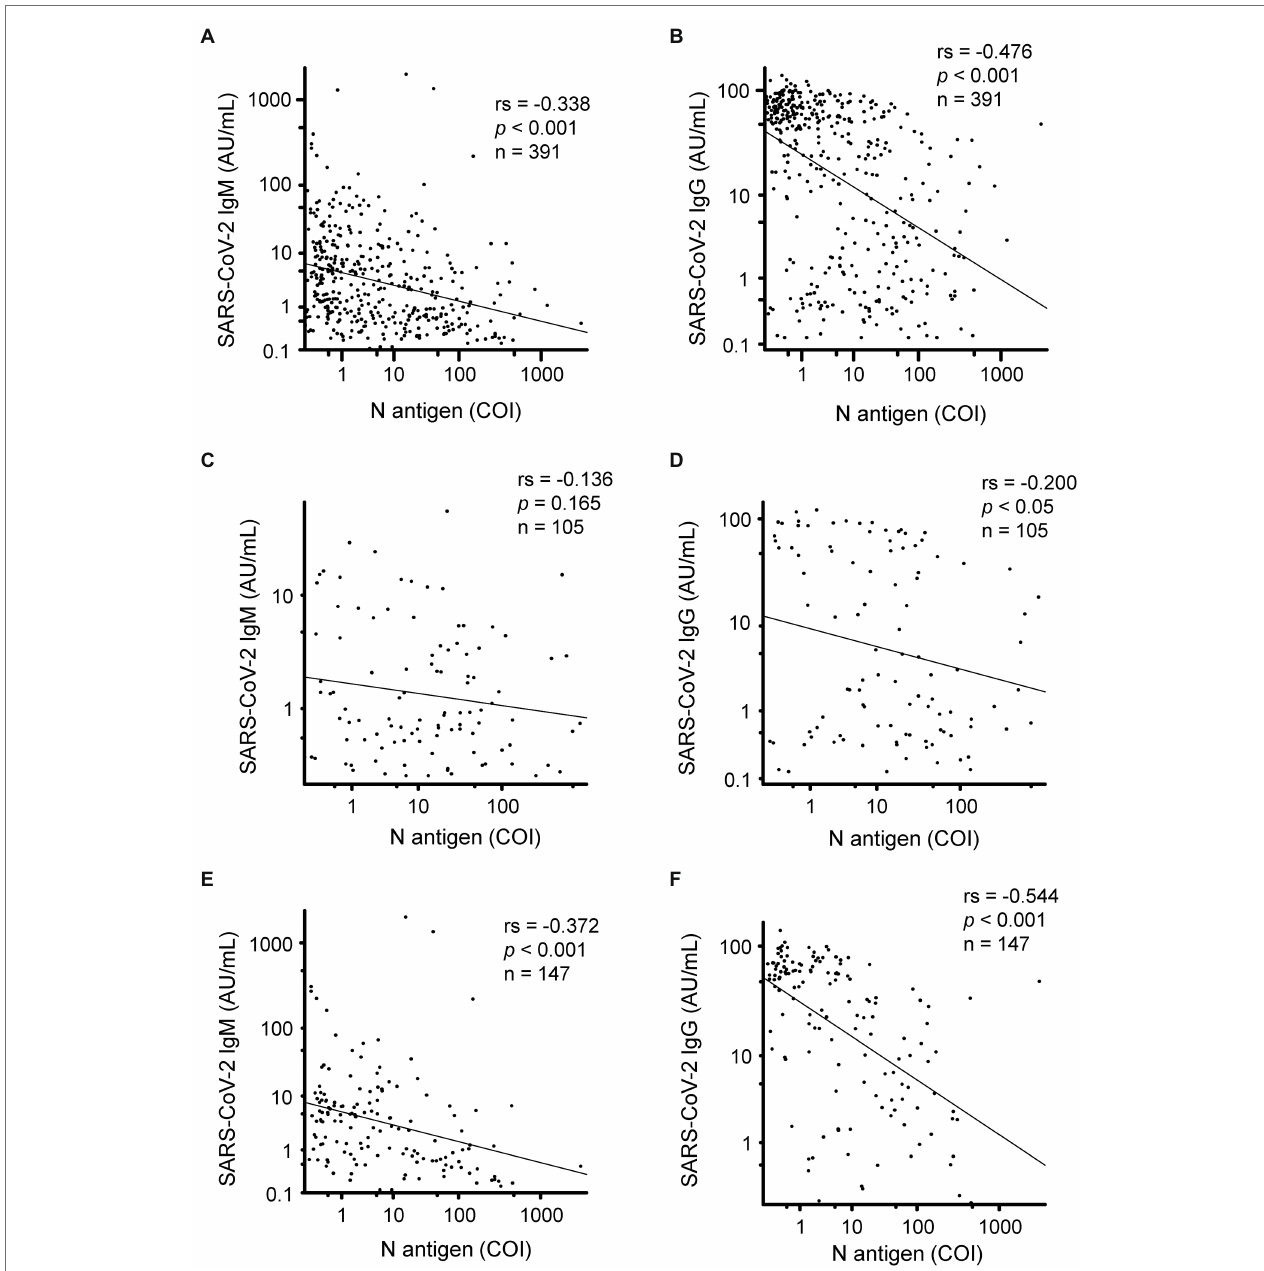
FIGURE 4 | Correlation of the serum N antigen levels with the SARS-CoV-2 specific antibody titers. We compared the serum N antigen levels in relation to the SARS-CoV-2 IgM/IgG titers in samples collected between 1 and 16 days (A,B) , 5 and 8 days (C,D) , and 9 and 12 days (E,F) after symptom onset. rs, spearman’s rank correlation